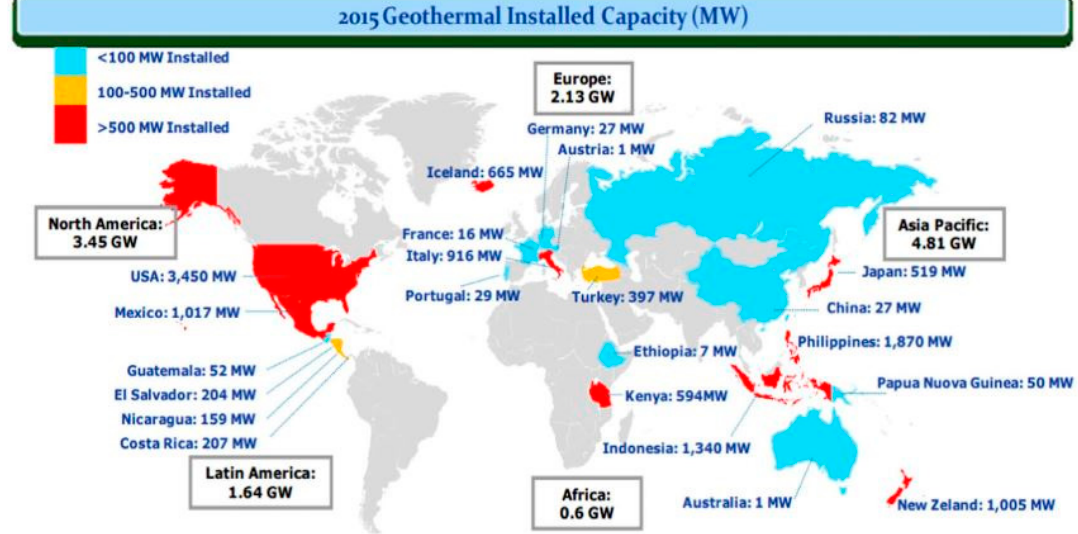
Figure 17. Geothermal installed capacity around the world. (1.96”, 1.96).